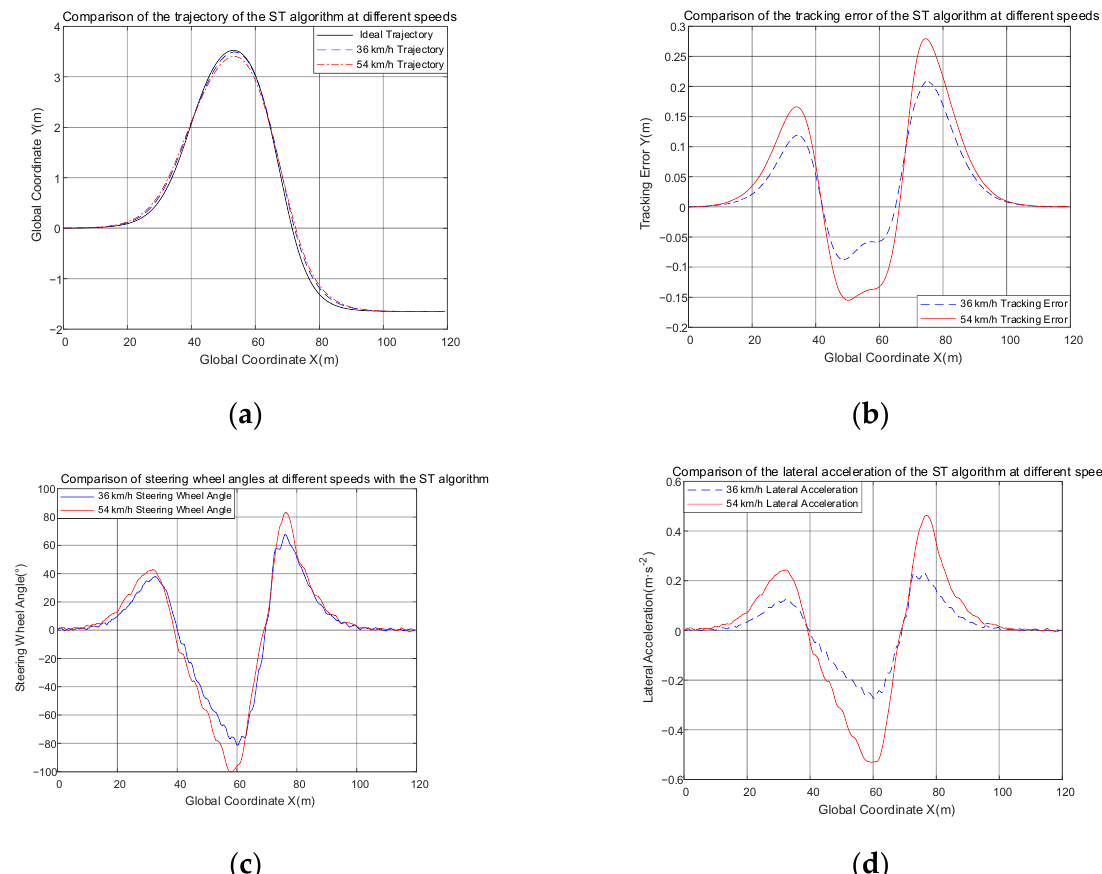
Comparison of steering wheel angles at different speeds with the ST algorithm 36 km/h Steering Wheel Angle